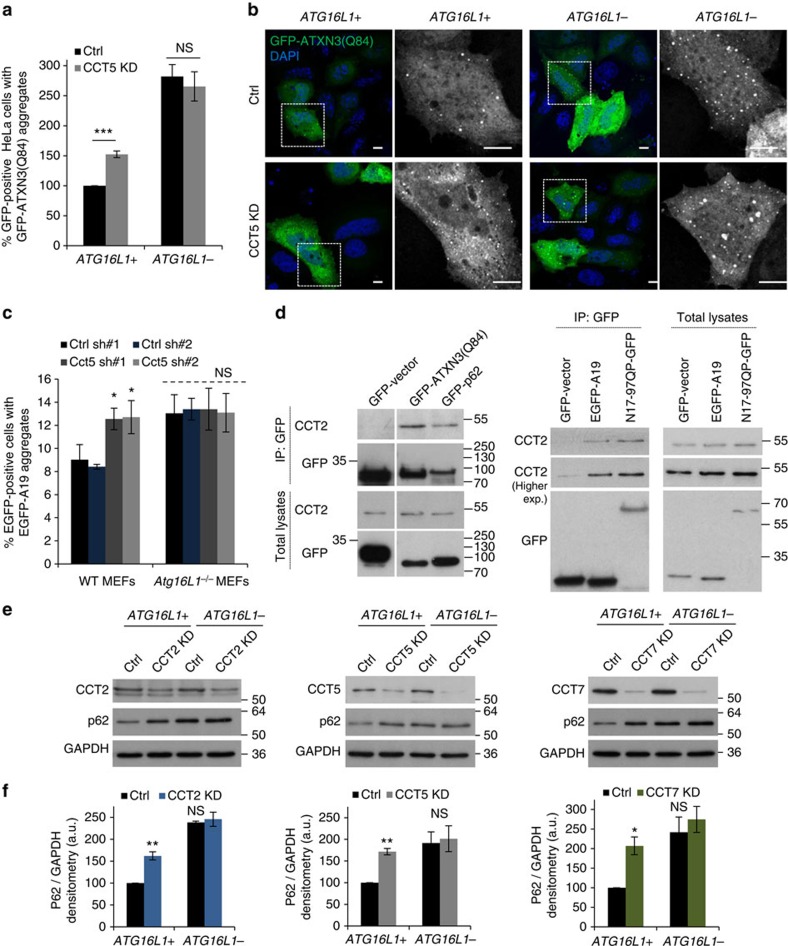
CCT depletion increases the accumulation of diverse autophagy substrates.(a) GFP-ATXN3(Q84) aggregation in CCT-depleted ATG16L1+ and ATG16L1- HeLa cells. The bars represent the mean of the percentages of cells with aggregates±s.e.m. (n=4 independent experiments, each performed in triplicates; ***P<0.001, NS, not significant; one sample t-test). (b) Representative images of GFP-ATXN3(Q84) aggregates for the experiments performed in a. Scale bar throughout the panel is 10 μm. (c) EGFP-A19 aggregation in WT and Atg16L1−/− MEFs. Cells seeded on coverslips in triplicates, were transduced with two different shRNA lentiviral particles targeting either control or the mouse Cct5 subunit and transfected with EGFP-A19. The bars represent the mean of percentages of cells with aggregates±s.d. (n=3; *P<0.05, NS, not significant; two-tailed t-test). Similar data was achieved in other two independent experiments. (d) CCT co-immunoprecipitation with the GFP-ATXN3(Q84), GFP-p62 (on the left ) and EGFP-A19, N17-97QP-GFP (on the right). HeLa cells were transfected with GFP-vector or the above mentioned proteins tagged to GFP for 16 h; the GFP-tagged proteins were pulled-down using the GFP-Trap technology. (e) Western blotting for p62. ATG16L1+ and ATG16L1− CRISPR/Cas9 HeLa cells were transfected with siRNA targeting individual CCT subunits. GAPDH was used as loading control. (f) Quantification of p62 accumulation. ATG16L1+ and ATG16L1− CRISPR/Cas9 HeLa cells were transfected with siRNA targeting individual CCT subunits as in (e). GAPDH was used as loading control. The bars represent the mean±s.d. (n=3; **P<0.01, *P<0.05, NS, not significant; two-tailed one sample t-test). Similar results were observed in three independent experiments.